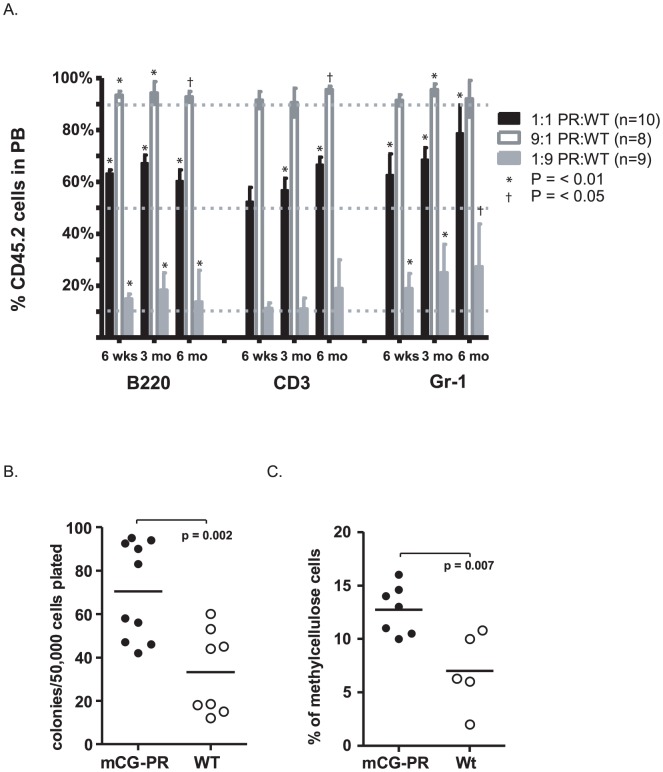
Effects of Ctsg-PML-RARA on multi-lineage hematopoiesis.A. Effects on myeloid and lymphoid lineage hematopoiesis. Bone marrow cells from indicated mice at 6 weeks of age were mixed at ratios of 1∶1, 9∶1, or 1∶9 with competitor CD45.1+/CD45.2+ bone marrow cells from sex- and age-matched mice. These cells were transplanted into sex-matched, 6-week-old, lethally irradiated CD45.1+ recipients. At the indicated time points, peripheral blood was assessed for ratios of CD45.2+ and CD45.1+/CD45.2+ white blood cells within the B220+, CD3+, or Gr1+ compartments. One sample, two-tailed t-test compared outcomes with the expected values of 10%, 50%, or 90%. Alpha was set at 0.05. Time points with p<0.01 (*) and p<0.05 (†) are indicated. B–C. Effect of Ctsg-PML-RARA on erythroid lineage hematopoiesis. Bone marrow cells from 6-week-old and 8-week-old, healthy mice were plated in methylcellulose containing erythropoietin. B. Total colonies after one week in culture (each data point represents results from an individual mouse in three combined experiments). Results of paired t-test between WT and mCG-PR samples are shown (p-value = 0.002). C. After one week in culture, total colony cells were washed and the number of immature erythrocytes (cKit+CD71dim) was assessed. Results of a paired t-test between WT and mCG-PR samples are shown (p-value = 0.007).